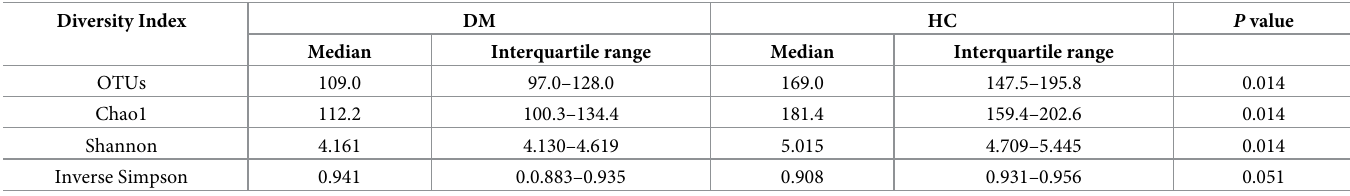
Table 2. Diversity comparison between healthy respiratory controls and diabetic subjects. Diversity